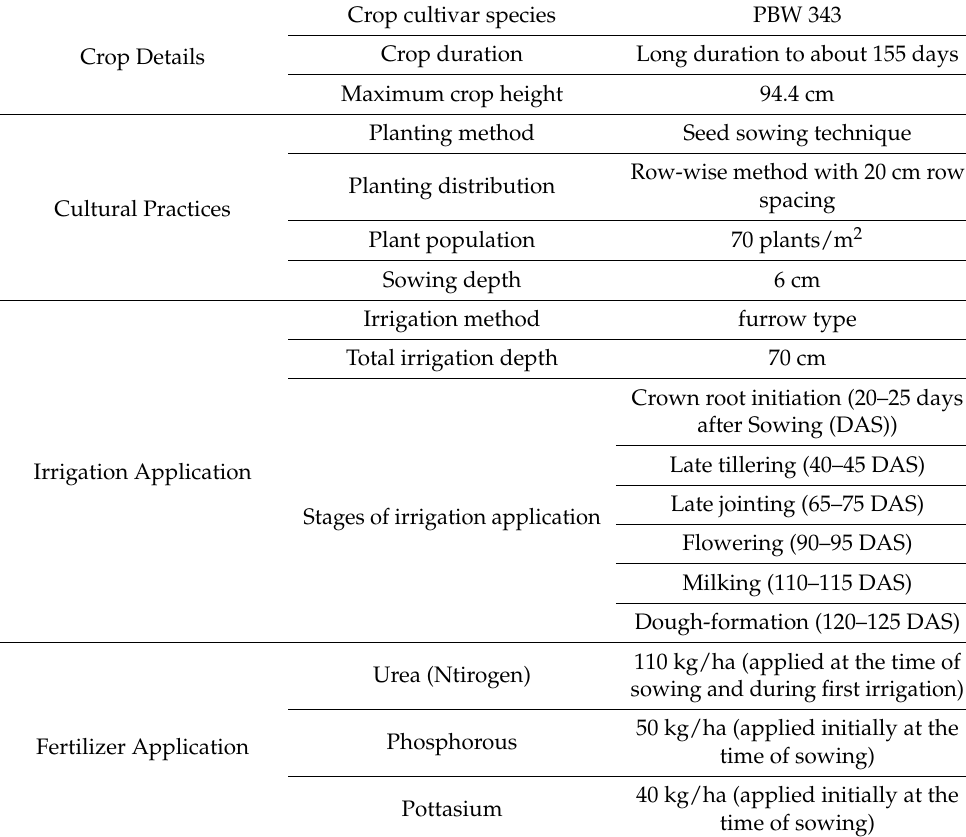
Table 3. Crop cultural and management